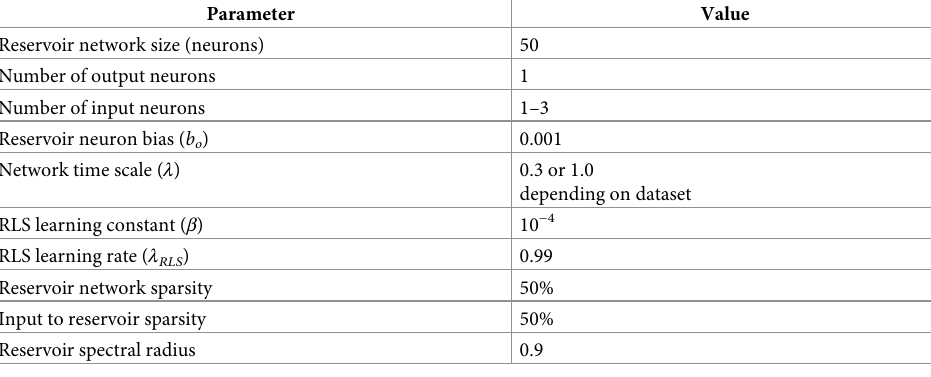
Table 1. List of the reservoir-based network parameter